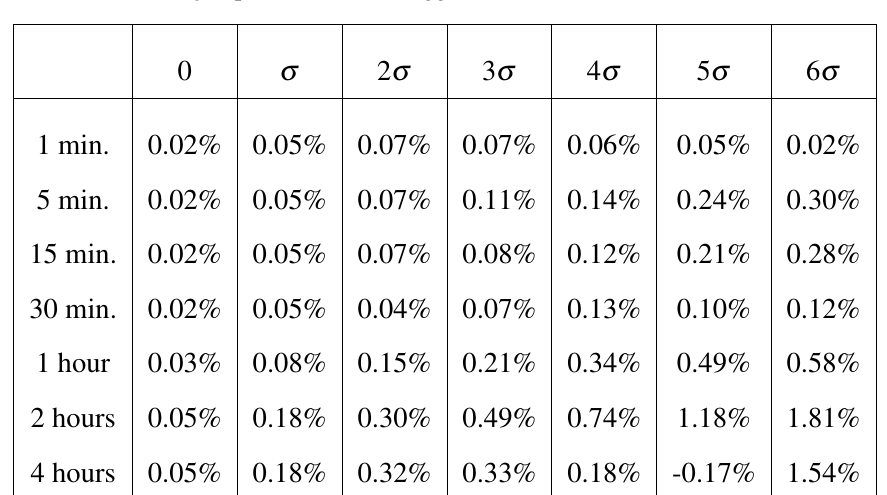
Table 5. Mean per-trade profitability of a basic mean-reverting strategy. Results are sorted by timeframe (row) and jump size needed to trigger a trade